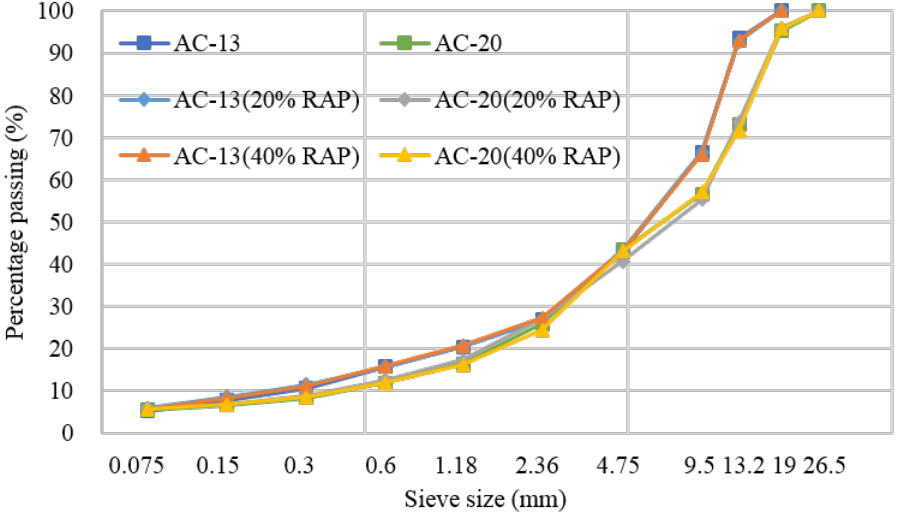
Figure 5. Gradation of different asphalt mixtures.